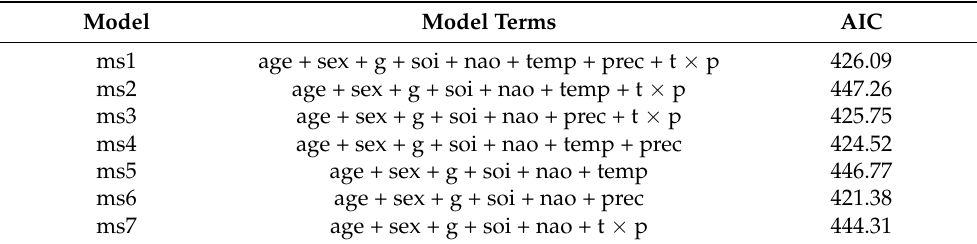
Table A1. Model selection for local climate variables using Akaike information criterion (AIC) with both large-scale climate variables NAOI and SOI being included.